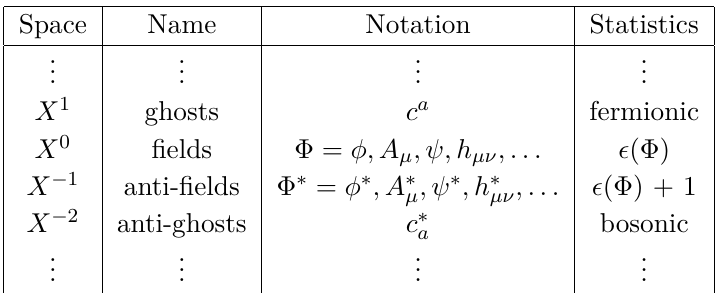
Table 1 . Extended field space in the BV